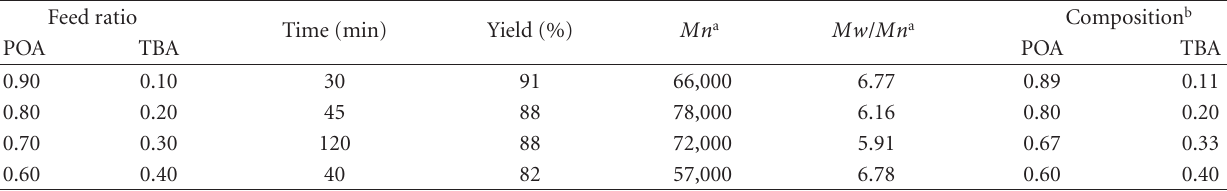
Table 1: The P(POA- r -TBA)